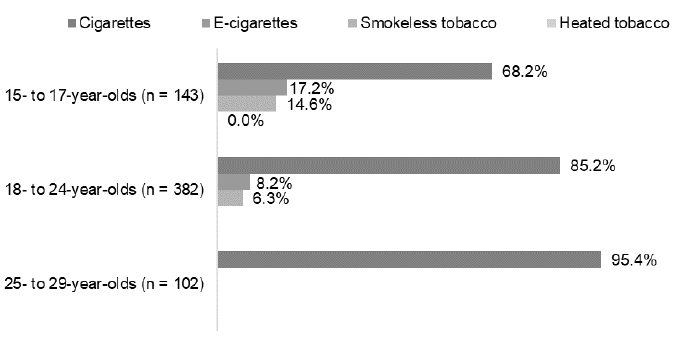
Figure 3. Type of tobacco or nicotine product used first, stratified by age groups. Data for the use of heated tobacco among 18–24-year-olds as well as data for the use of e-cigarettes, smokeless